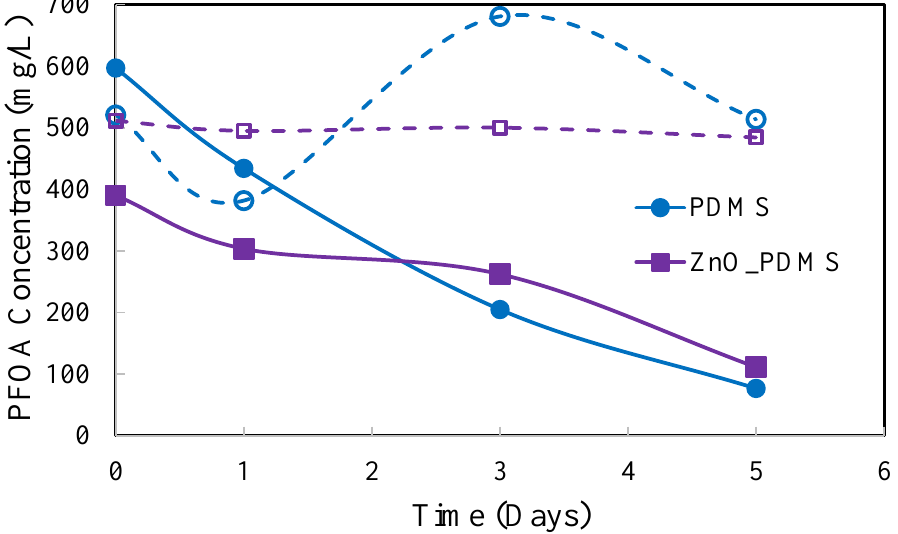
Figure 11. Perstraction of PFOA from DI water (solid lines) and from tap water (dashed lines). 1-hexanol was the solvent. PDMS and 0.10 ZnO-PDMS were the membranes used (3.5 g, 1 mm thickness).